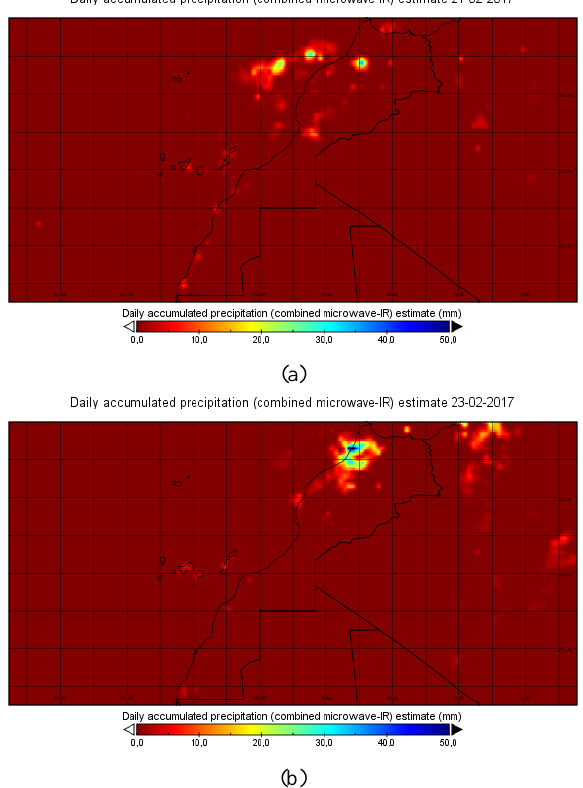
Figure 8. Rainfall maps before (a) and during (b) the flood